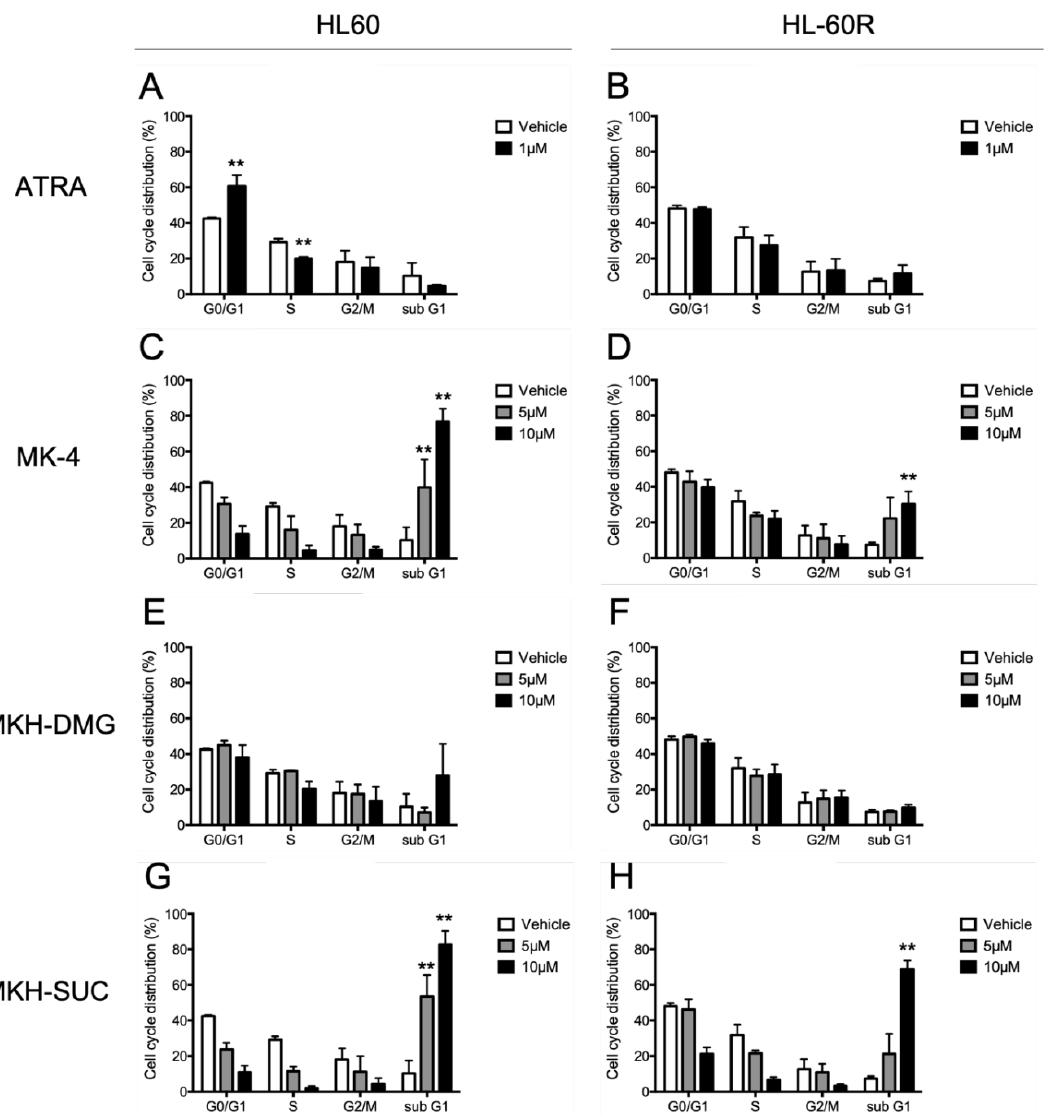
Figure 5. Effects of ATRA, MK-4, and MKH derivatives on the cell cycle distribution of HL60 and HL-60R cells. HL60 ( A , C , E , G ) and HL-60R ( B , D , F , H ) cells were treated with 1 µ M ATRA ( A , B ), 5 or 10 µ M MK-4 ( C , D ), 5 or 10 µ M MKH-DMG ( E , F ), or 5 or 10 µ M MKH-SUC ( G , H ) for 72 h. Cell cycle distribution was analyzed by flow cytometry after PI staining. Data are shown as mean ± SD from triplicate experiments. ** p < 0.01 by Dunnett’s test.